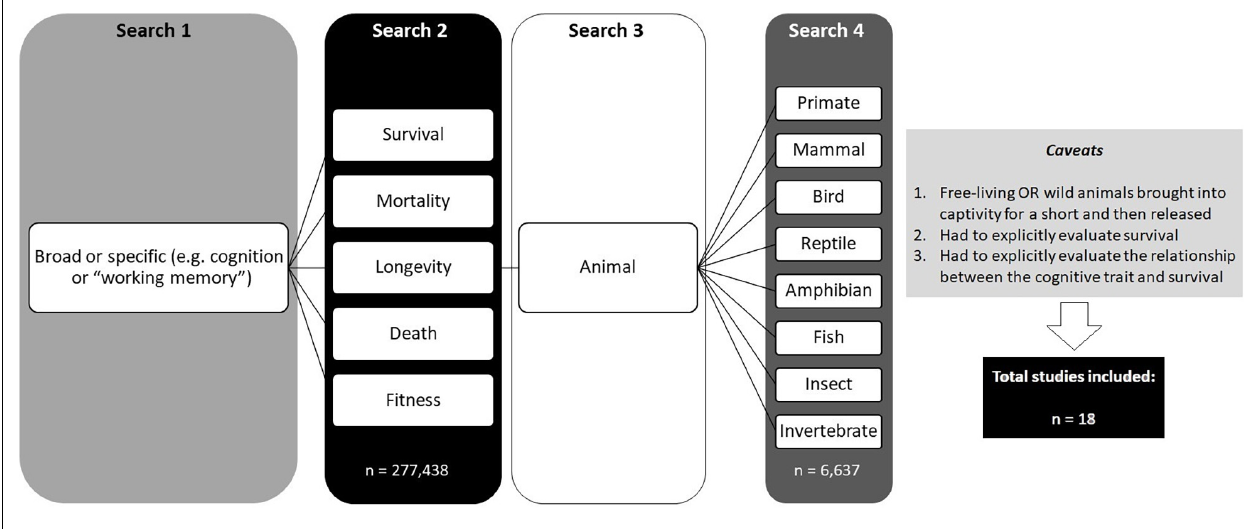
FIGURE 1 | Flow diagram showing the literature search process and the criteria used to include/exclude papers in the review.